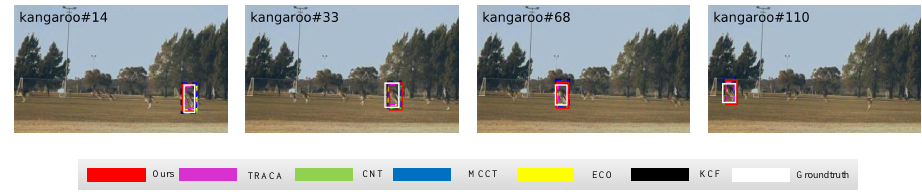
Figure 24. Qualitative results on the kangaroo sequence in color.